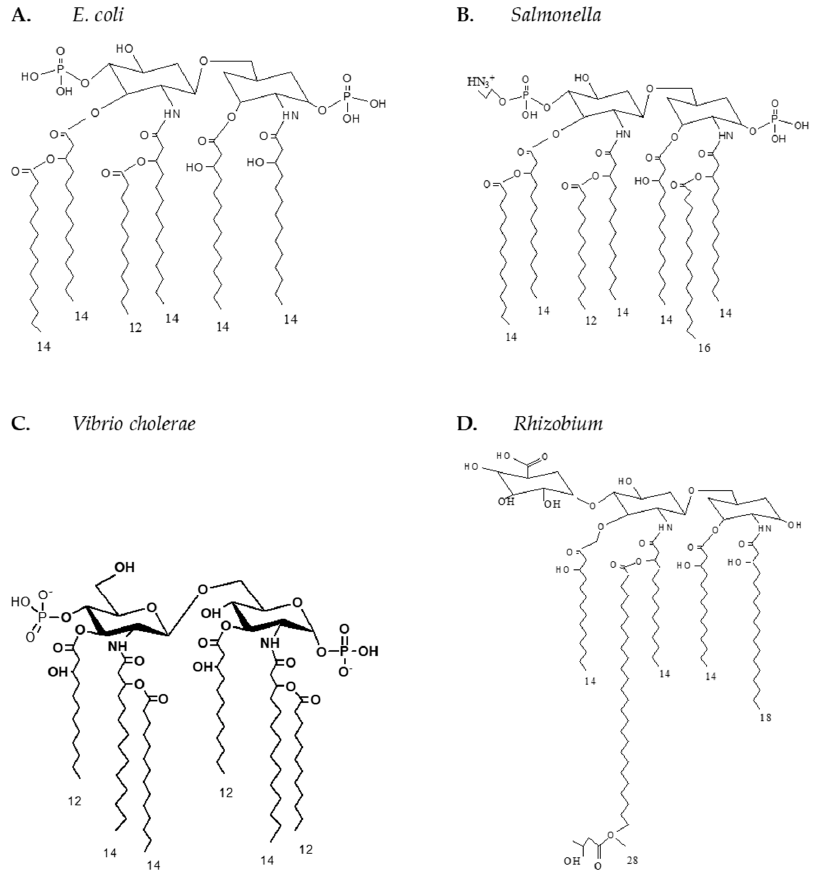
Figure A2. Schematic representation of different enteric lipid A structures. ( A ): E. coli ; ( B ): Salmonella ; ( C ): Vibrio cholerae ; ( D ): Rhizobium .